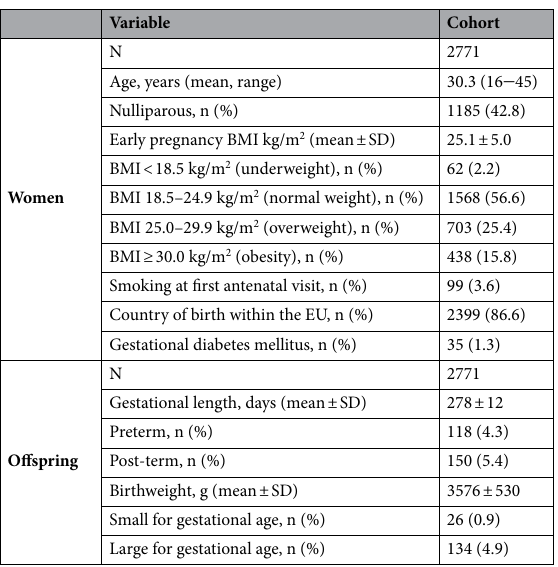
Table 1. Descriptive characteristics of the study population. BMI body mass index, preterm, < 37 + 0 weeks of gestation; post-term, > 41 + 6 weeks of gestation; small for gestational age, birthweight below minus two standard deviation scores of the mean birthweight for the gestational age and sex 30 ; large for gestational age, birthweight above plus two standard deviation scores of the mean birthweight for the gestational age and sex 30 .